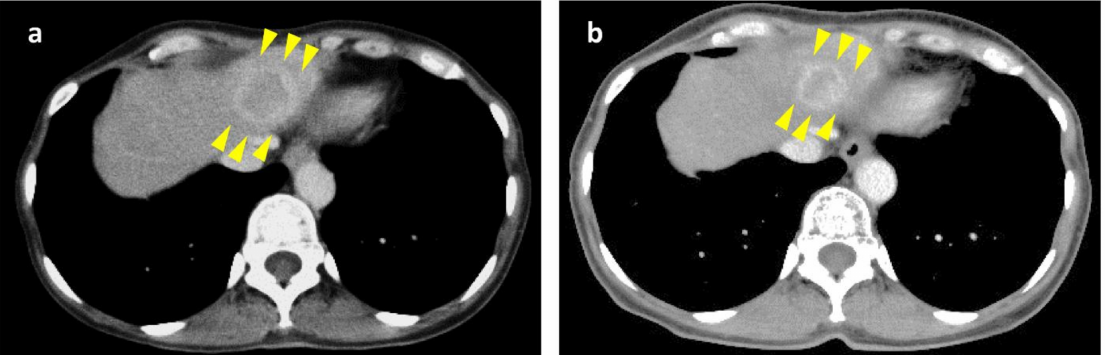
Figure 3. Cases with a good response to rechallenge with everolimus. ( a ) Contrast CT before everolimus rechallenge; target tumor diameter 34 mm. ( b ) Contrast CT 3 months after everolimus rechallenge; target tumor diameter 22 mm; PR response